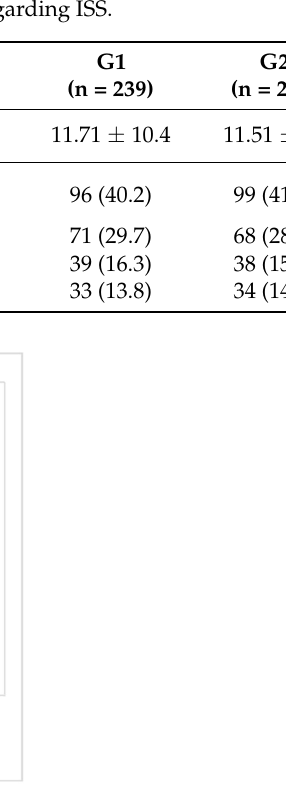
Figure 2. Matched predictors’ standardised difference (propensity score matching).